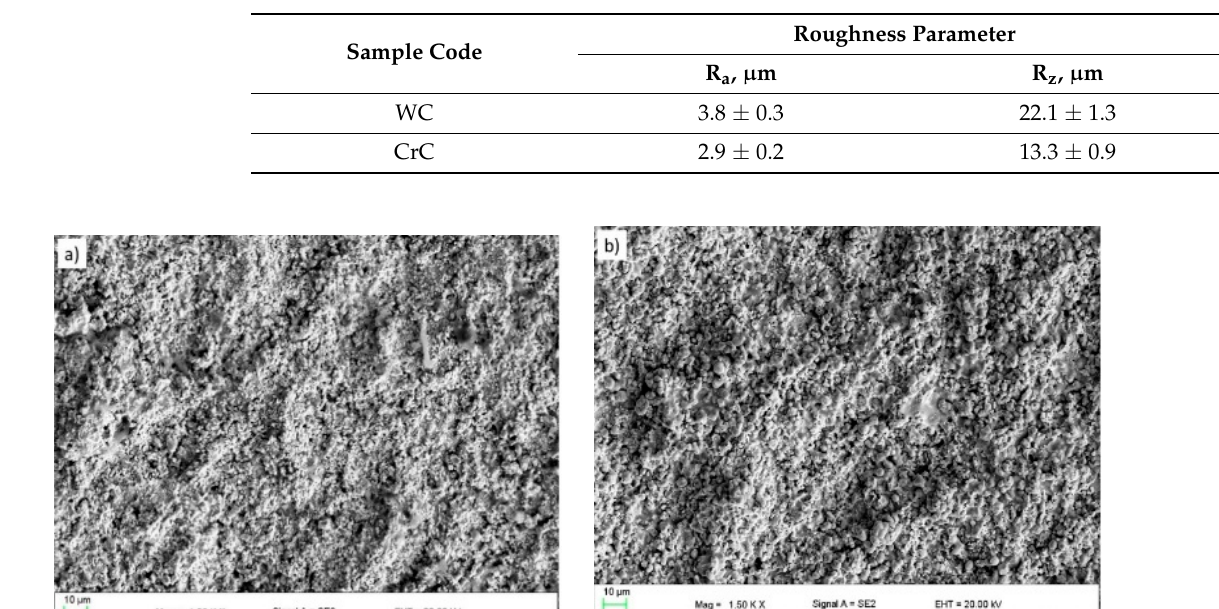
Table 5. The average surface roughness of the coatings in the as-sprayed condition.